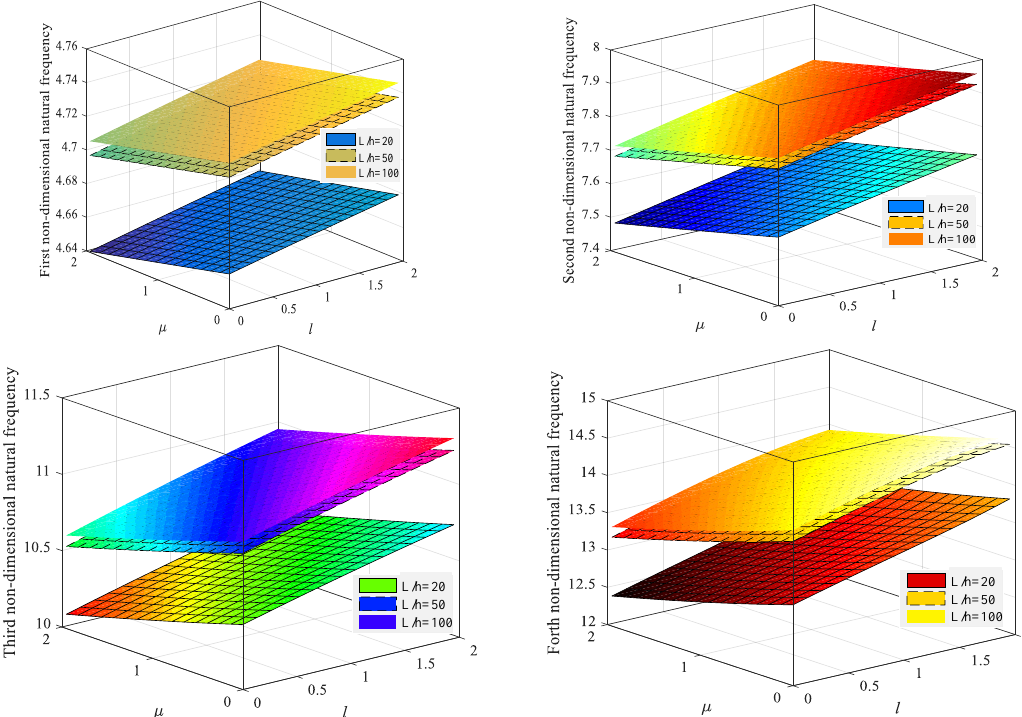
Figure 4. Variation of the first four natural frequencies for different L/h and small-scale parameters (clamped-clamped nanobeam).